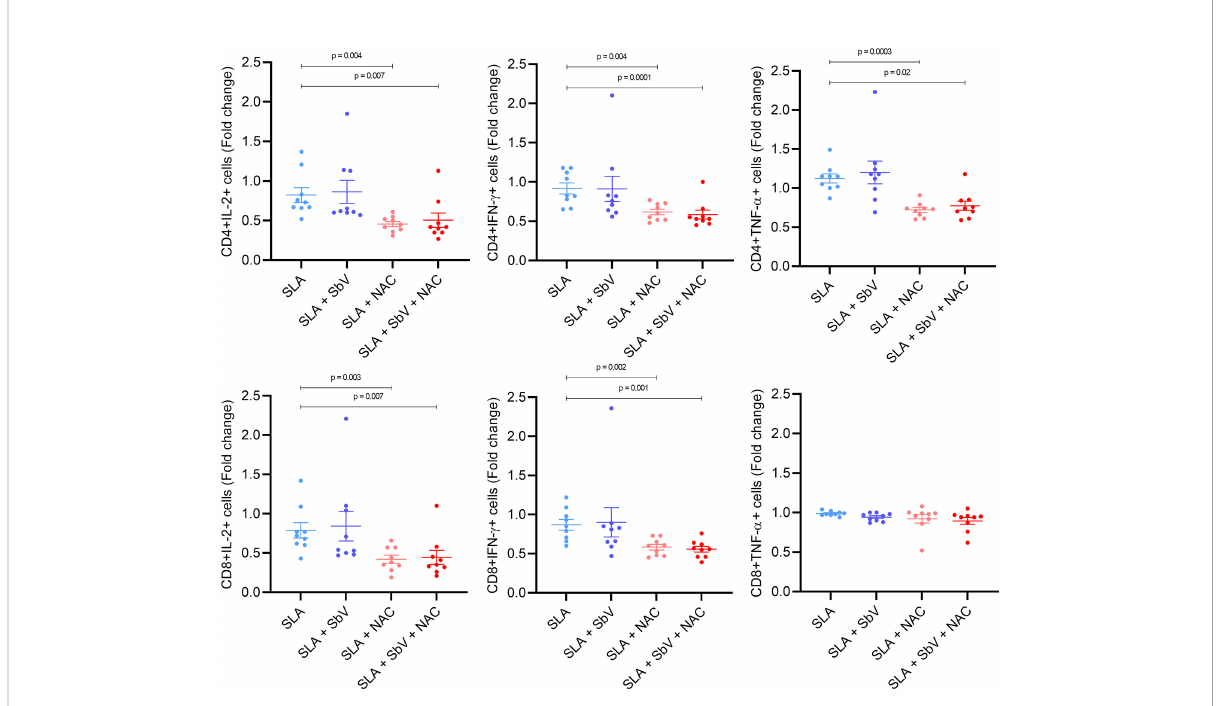
FIGURE 3 Frequency of CD4+ and CD8+ T cells producing IL-2, IFN- g , or TNF- a in PBMCs stimulated with SLA and treated or not with SbV, NAC, and SbV + NAC. Graphs represent a fold change from unstimulated cells. Dots represent each healthy donor (n = 9), and lines represent mean ± SEM. Friedman test followed by Dunn ’ s test was used for